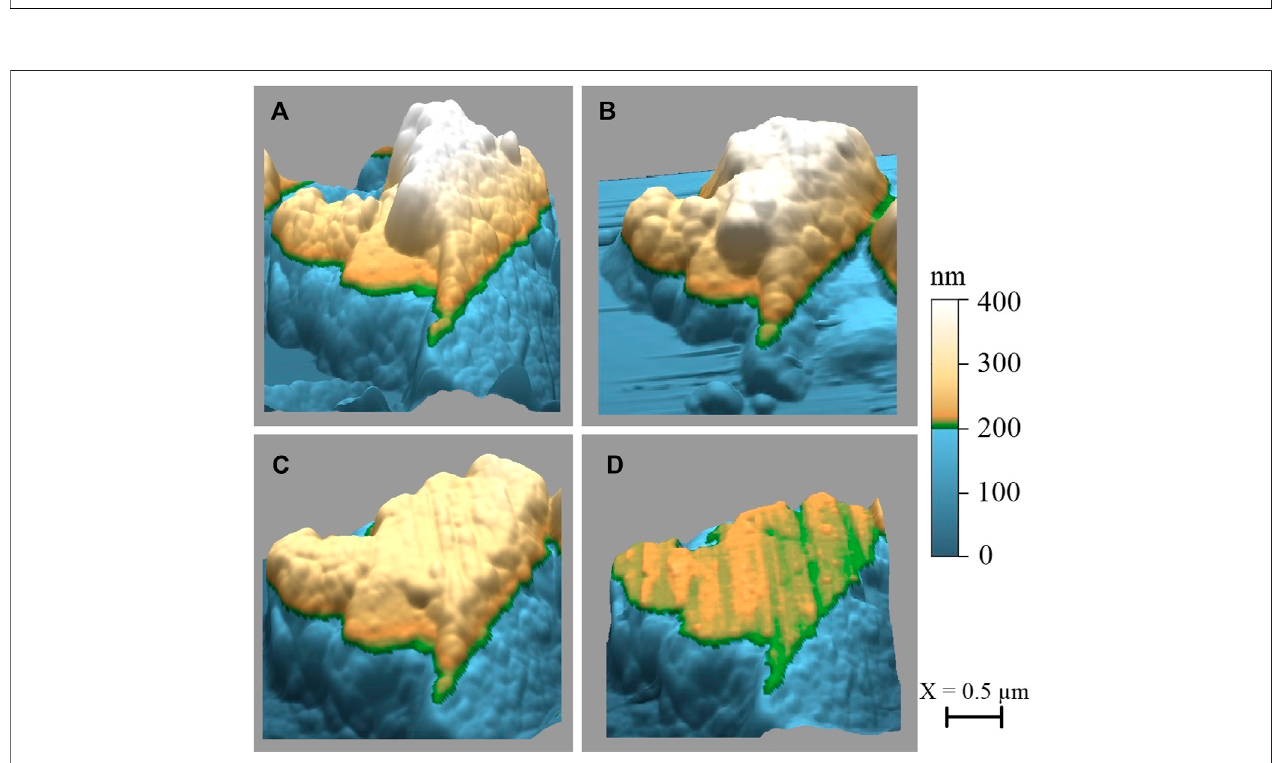
FIGURE14| TopographiesoftestparticleNo.4before testing (A) and after eighttests withatotal sF N (cid:1) 5.66 μ Nm (B) ,onetestwith sF N (cid:1) 54.9 μ Nm (C) ,and two tests withatotal sF N (cid:1) 10.6 μ Nm (D) . The separation level betweenthe blue and the brown scale at 200 nm was adjusted tothe fi nalheightofthe worn surface (D) fora better comparison of the four